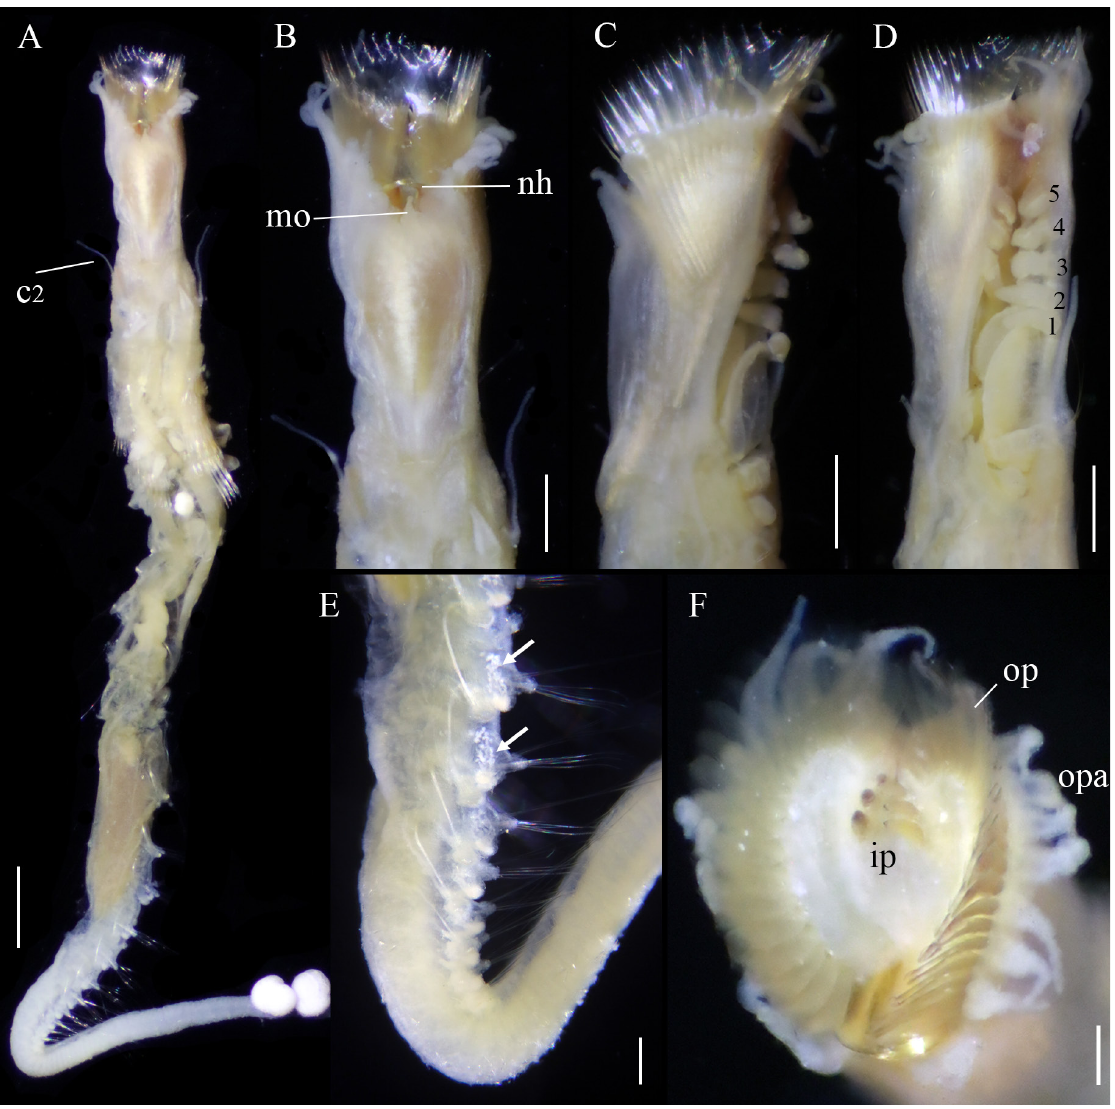
Fig. 20. Tetreres oscari sp. nov., holotype (UMML-22.1197). A . Complete specimen, dorsal view. B . Anterior region, dorsal view. C . Anterior region, lateral right view. D . Anterior region, ventral view. E . Last abdominal segments. F . Opercular crown, upper view. Abbreviations: c2 = cirri 2 nd thoracic segment; ip = inner paleae; mo = median organ; nh = nuchal hooks; opa = opercular papillae; op = outer paleae. Numbers indicate the tentacular filaments. Arrows indicate gametes. Scale bars: A = 1 mm; B–D = 0.5 mm; E–F = 0.2